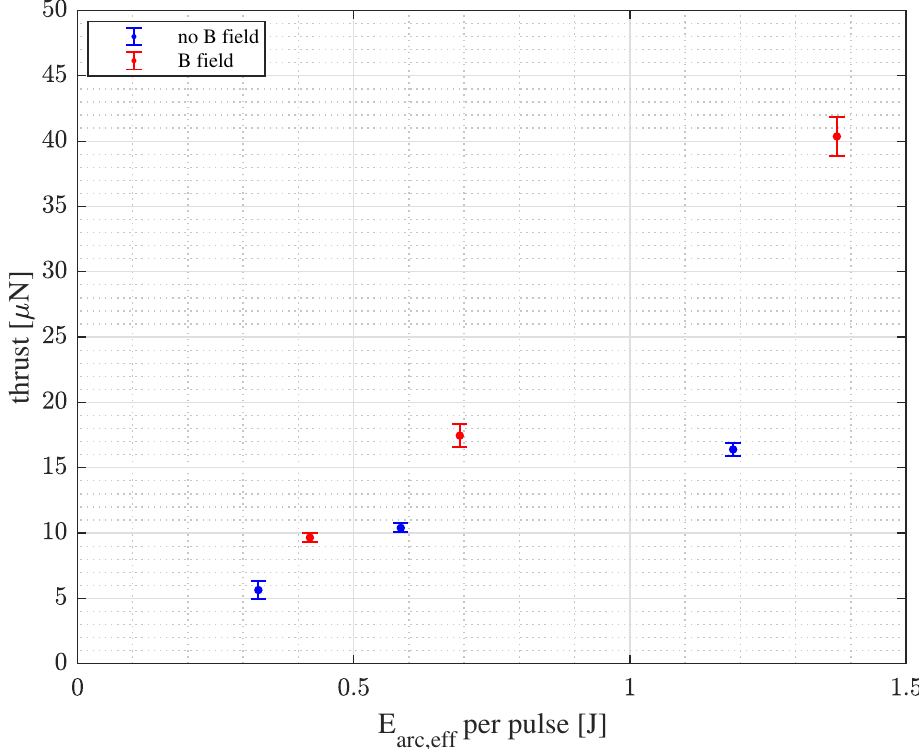
Figure 7. Average thrust in dependence of different energies dissipated in the arc with (red) and without (blue) magnetic field. The error bars indicate the standard deviation of the